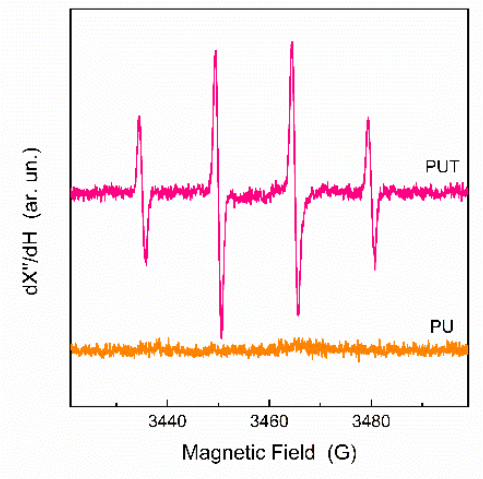
Figure 7. Room temperature DMPO spin-trapping EPR spectra of the PUT and PU composites in aqueous suspensions under 15 min of light irradiation.